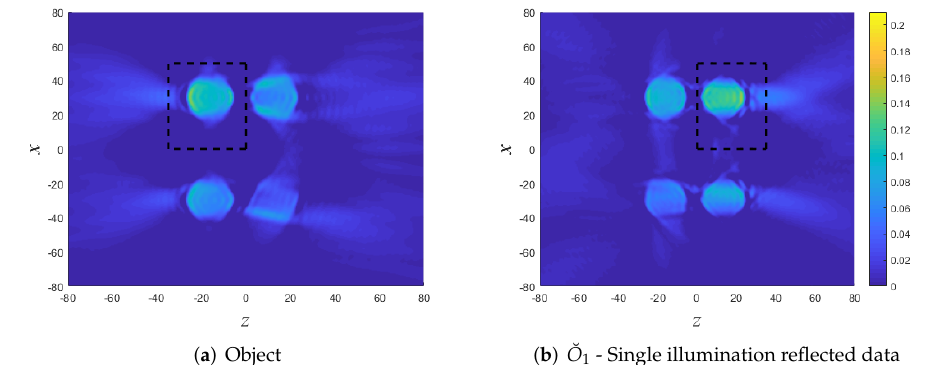
Figure 11. Numerical example B: Local reconstruction in different DoI’s (black rectangles). ( a ) Recon- struction of a cylinder at the front using both reflection and transmission data due to illumination at θ i = 0. ( b ) Reconstruction of a cylinder in the back using both reflection and transmission data from several illumination